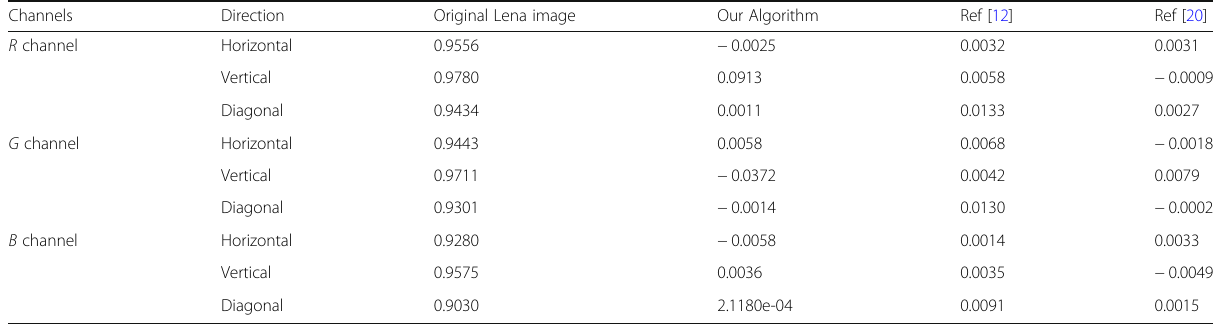
Table 3 Correlation coefficients in R , G , B channels